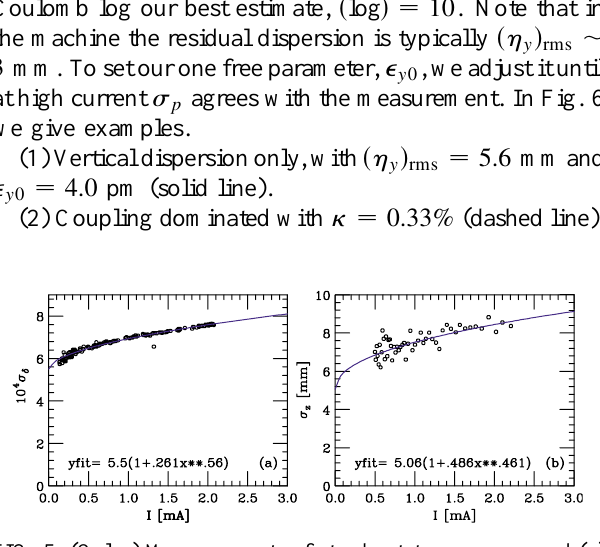
FIG. 5. (Color) Measurements of steady-state energy spread (a) and bunch length (b), with V c (cid:1) 300